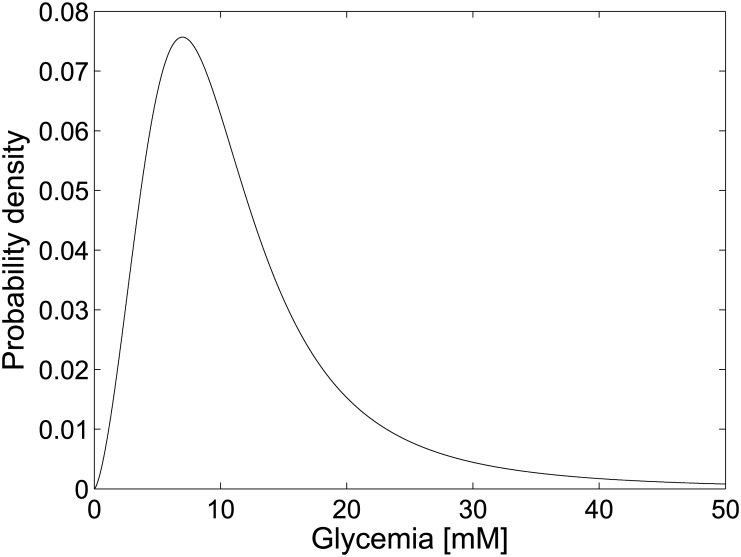
Probability density function of the controller firing thresholds G
n.